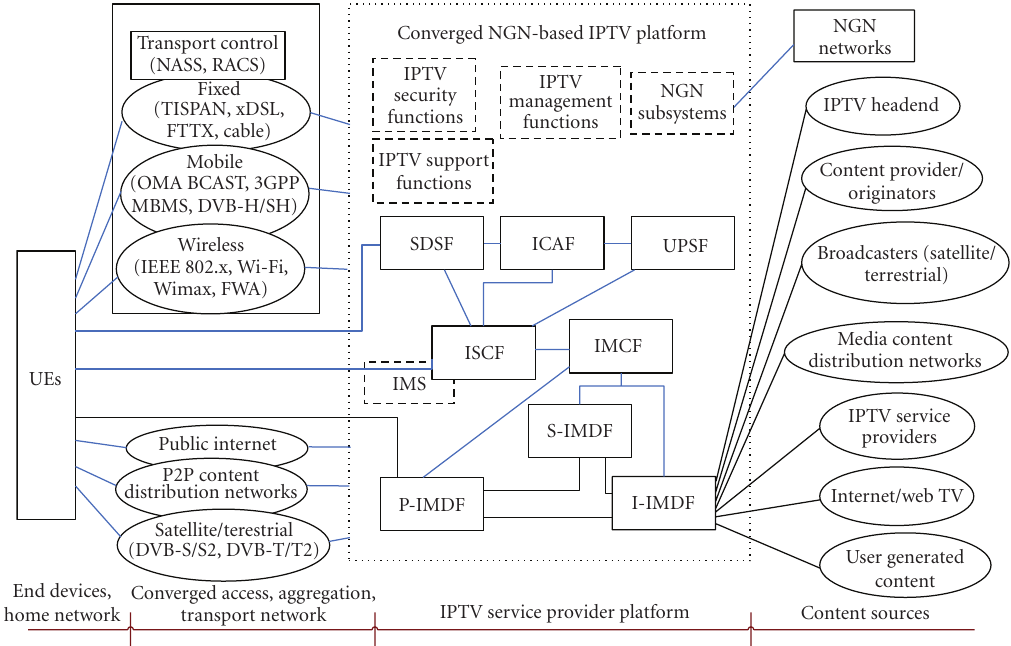
Figure 3: Proposed conceptual architecture for Converged NGN-based